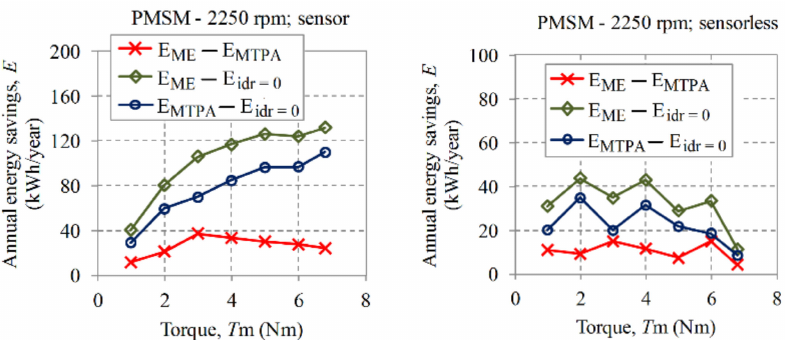
Figure 11. Annual energy savings achieved by di ff erent methods of reference current generation in the speed closed-loop controlled PMSM drive for the realization with the mechanical sensor and for the sensorless